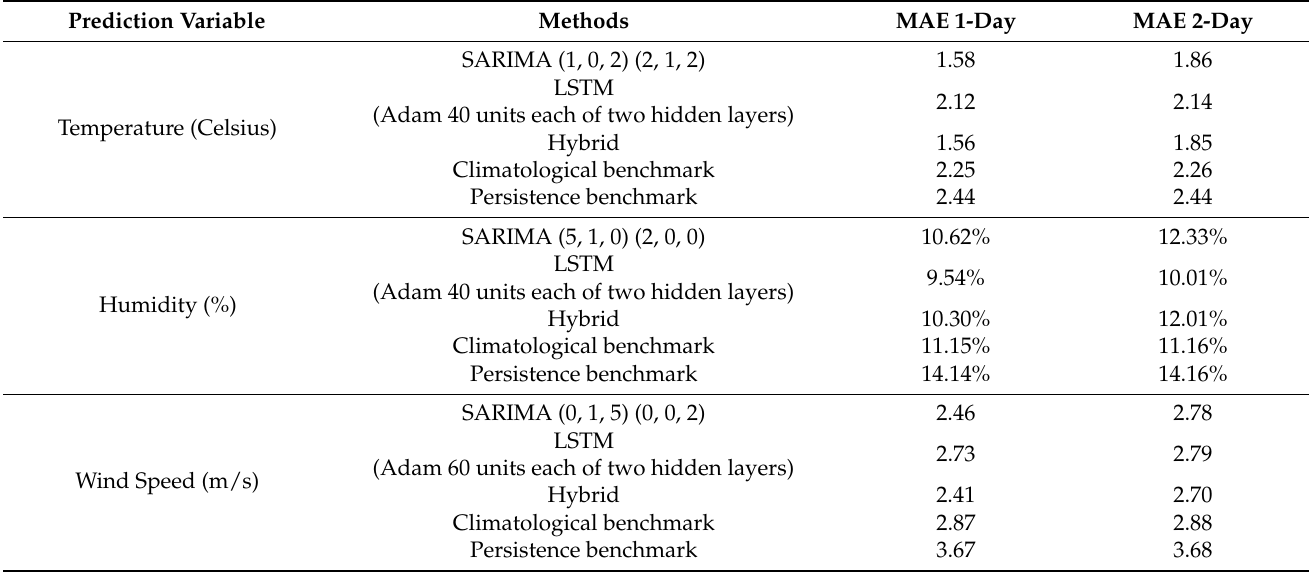
Table 1. MAE errors for the three methods for 1- and 2-day prediction of wind speed (m/s) for the three predicted variables, averaged over each day and then over the test set. MAE units are the same as the predicted